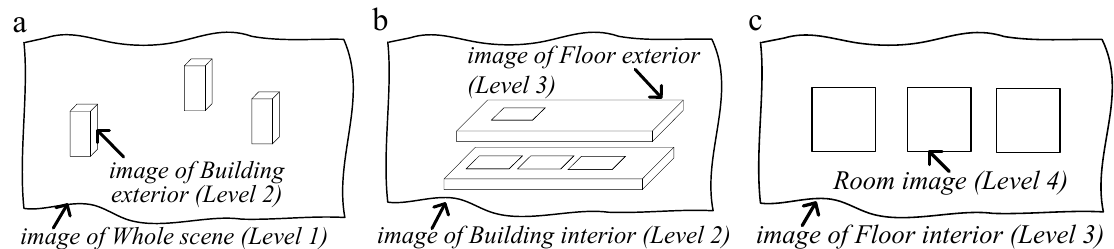
Figure 2. Four-layer monitored environment. ( a ) Image of the whole scene. ( b ) Image of the building interior. ( c ) Image of the floor interior.